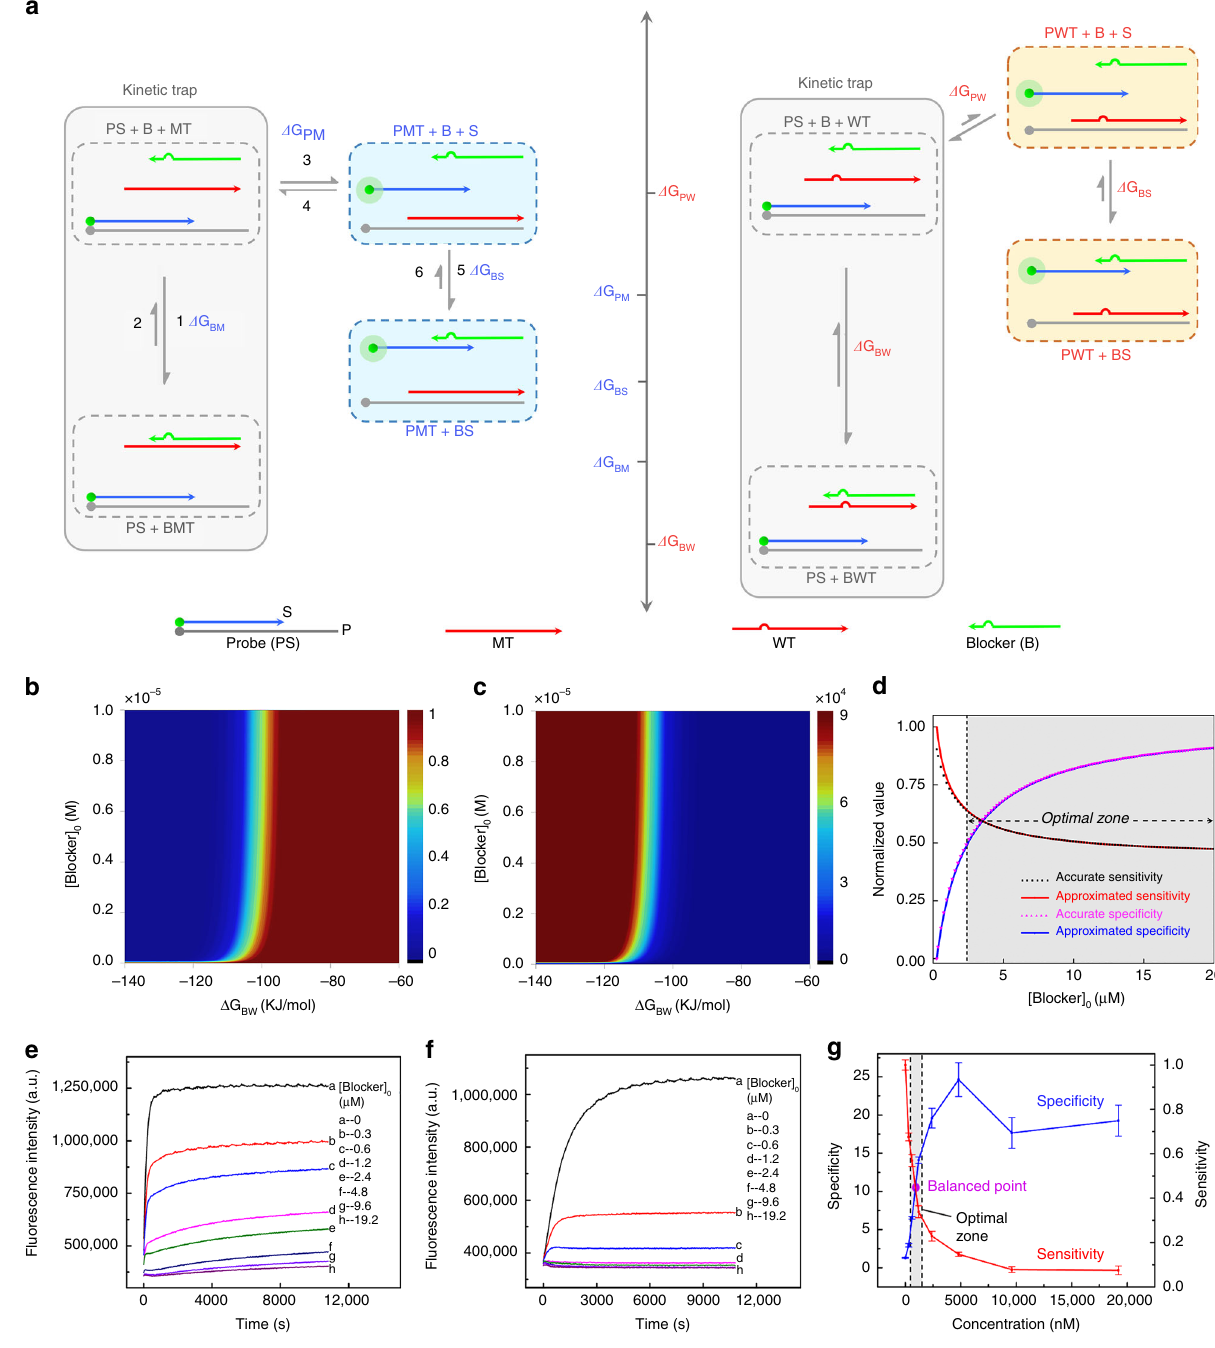
Fig. 2 Modelling and veri fi cation of the Strand displacement probe/standard blocker system. a The reaction pathways and the levels of associated free energy changes. b Calculated sensitivity of the system over [Blocker] 0 and Δ G BW . c Calculated speci fi city of the system over [Blocker] 0 and Δ G BW . d Two-dimensional interception curves of sensitivity and speci fi city extracted from ( b ) and ( c ). The value of Δ G BW was fi xed at − 101403Jmol − 1 . e – f The fl uorescence intensity of system towards MT ( e ) and WT ( f ) with the concentration of blocker ranging from 0 to 19.2 µ M. The length of blocker was fi xed at 18-nt. g The sensitivity and speci fi city of the system over [Blocker] 0. Error bars are s.d. of three repeated experiments. Source data are provided as a Source Date fi